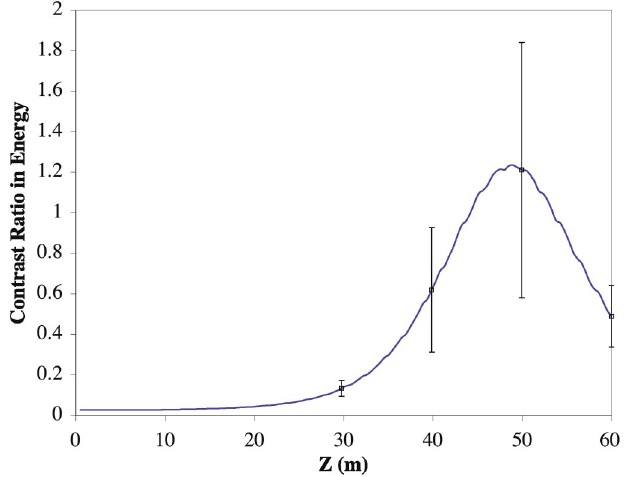
FIG. 9. (Color) Contrast ratio in terms of x-ray energy between the main current peak and the rest of the electron beam, includ- ing side peaks. Statistical fluctuations in the contrast ratio are indicated for several locations in z .